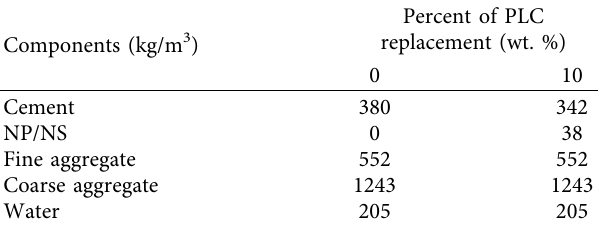
Table 2: Concrete mix